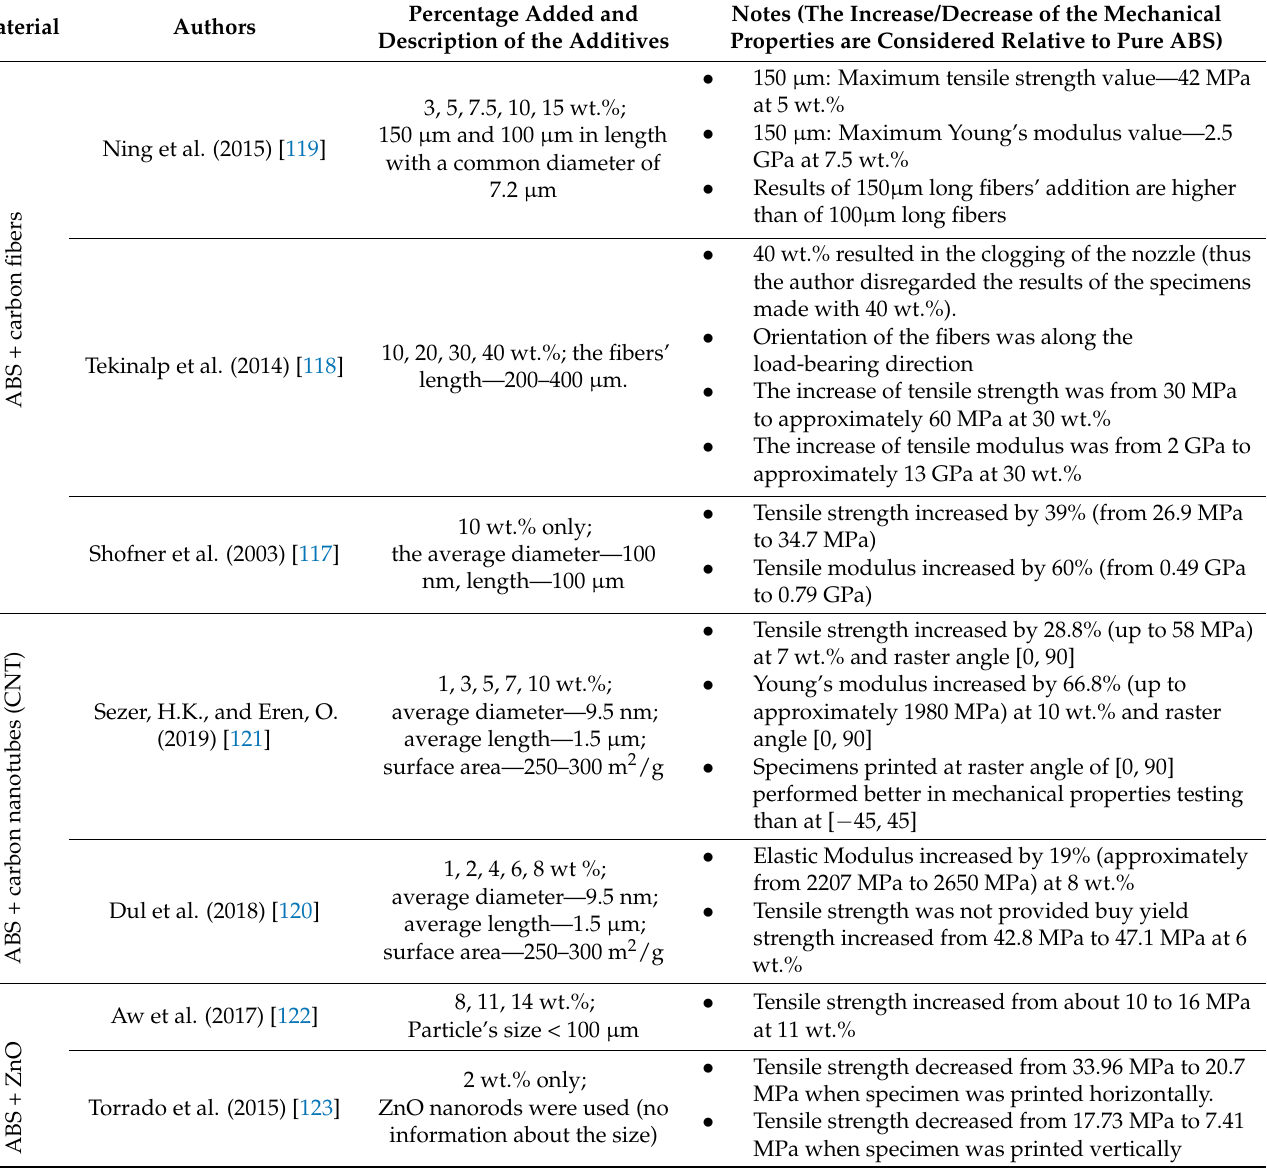
Table 4. Additive composite materials for